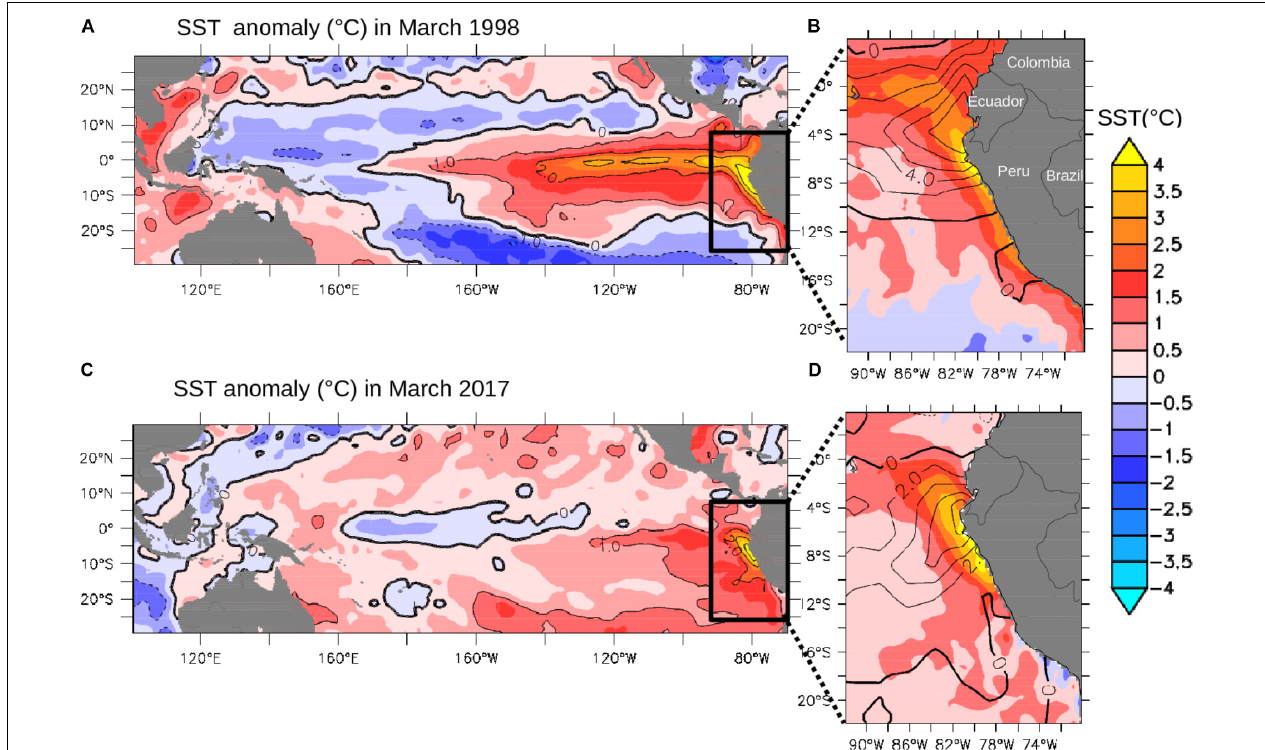
FIGURE 1 | (A) SST anomaly (in ◦ C) and (B) SST anomaly (in ◦ C, color scale) and precipitation (in mm day − 1 , contours) during the 1997–1998 El Niño in March 1998; (C,D) are same as (A,B) during the 2017 coastal El Niño in March 2017. Anomalies were computed with respect to the 1981–2016